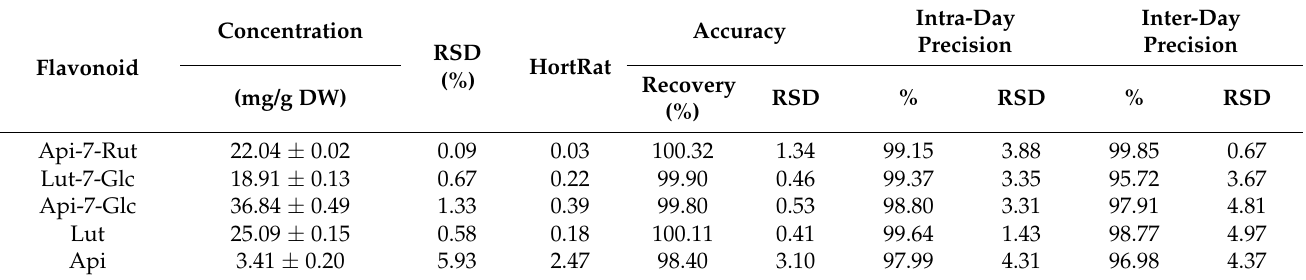
Table 3. Quantification and validation parameters for the simultaneous analysis of the main flavonoids from M. angustifolia leaf ethanolic